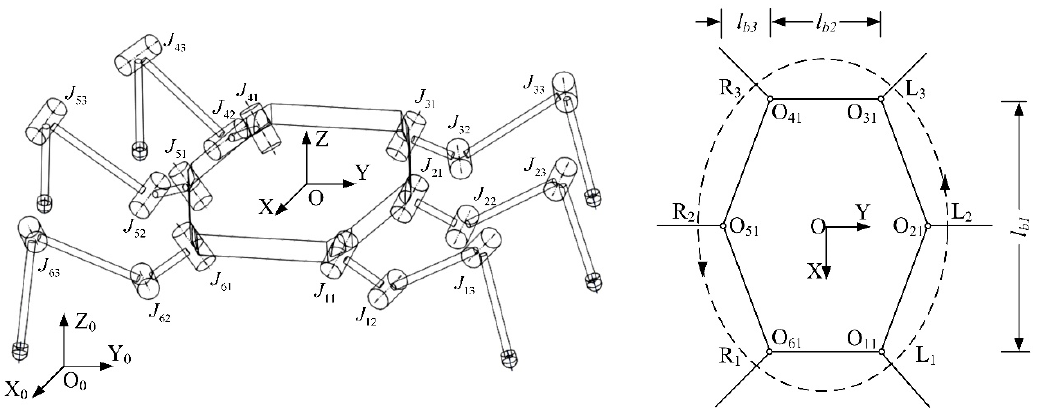
Figure 2. The reference coordinate system and the trunk coordinate system.